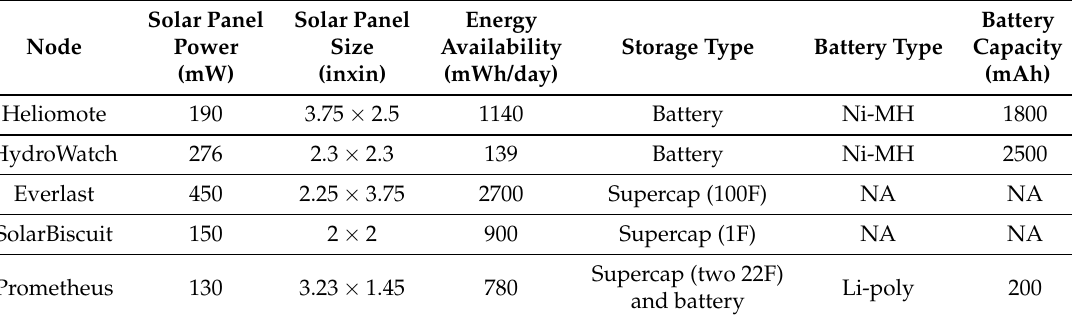
Table 2. Specifications of solar-energy-harvesting sensor nodes